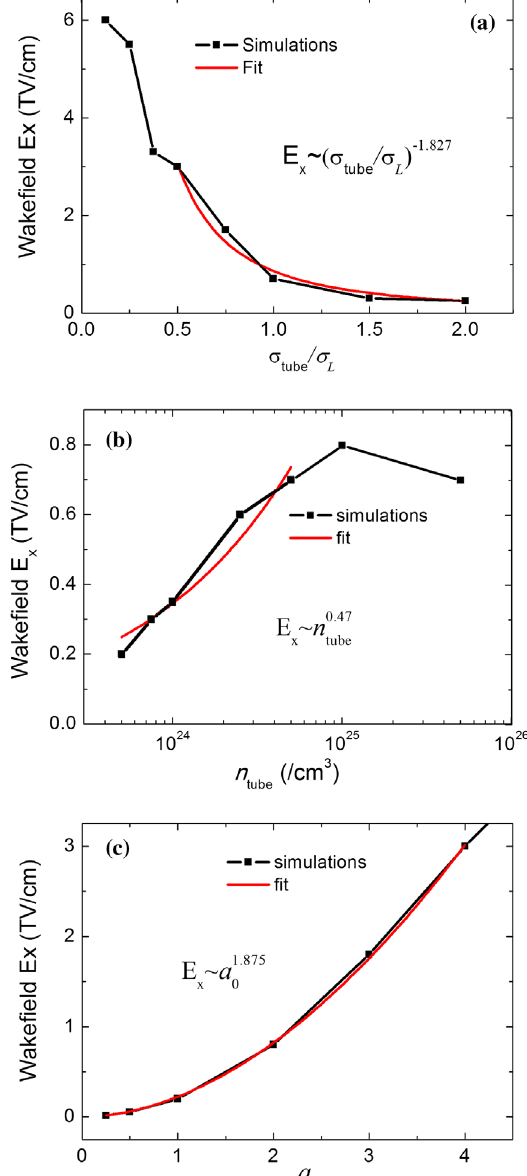
FIG. 7. Wakefield scalings in the x-ray regime with (a) tube radius, (b) tube wall density when the tube radius is fixed σ = σ ¼ 1 , and (c) laser intensity when the tube radius is L tube = σ ¼ 0 . 5 fixed σ L tube